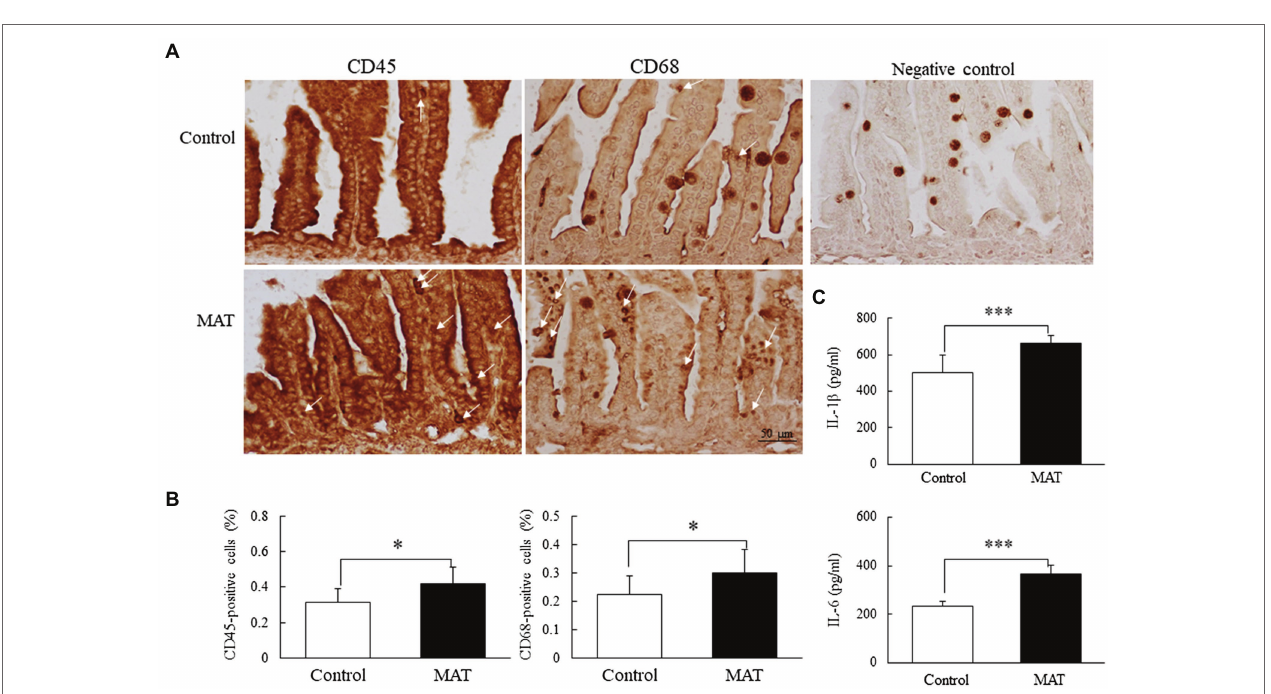
FIGURE 5 | Effects of MAT on (A) immunohistochemistry results, (B) results of quantitative analysis of CD45 and CD68 cells, and (C) cytokines in 7-day-old mice. CD45 and CD68 immunoreactivity was observed on the cytoplasm and cell membrane of the small lymphocytes. The CD45- and CD68-positive cells (white arrow) were scattered over the lamina propria and between the epithelial cells of the intestinal mucosa. The mice born to antibiotic-treated dams exhibited significantly higher percentages of CD45- and CD68-positive cells and higher IL-1 β and IL-6 expression levels than did those born to control dams. * p < 0.05; *** p < 0.001. MAT, maternal antibiotic